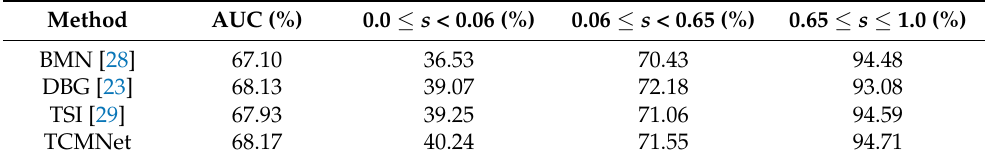
Table 5. Effectiveness of locating actions with different durations on the ActivityNet-1.3 validation set. s stands for the scale of ground